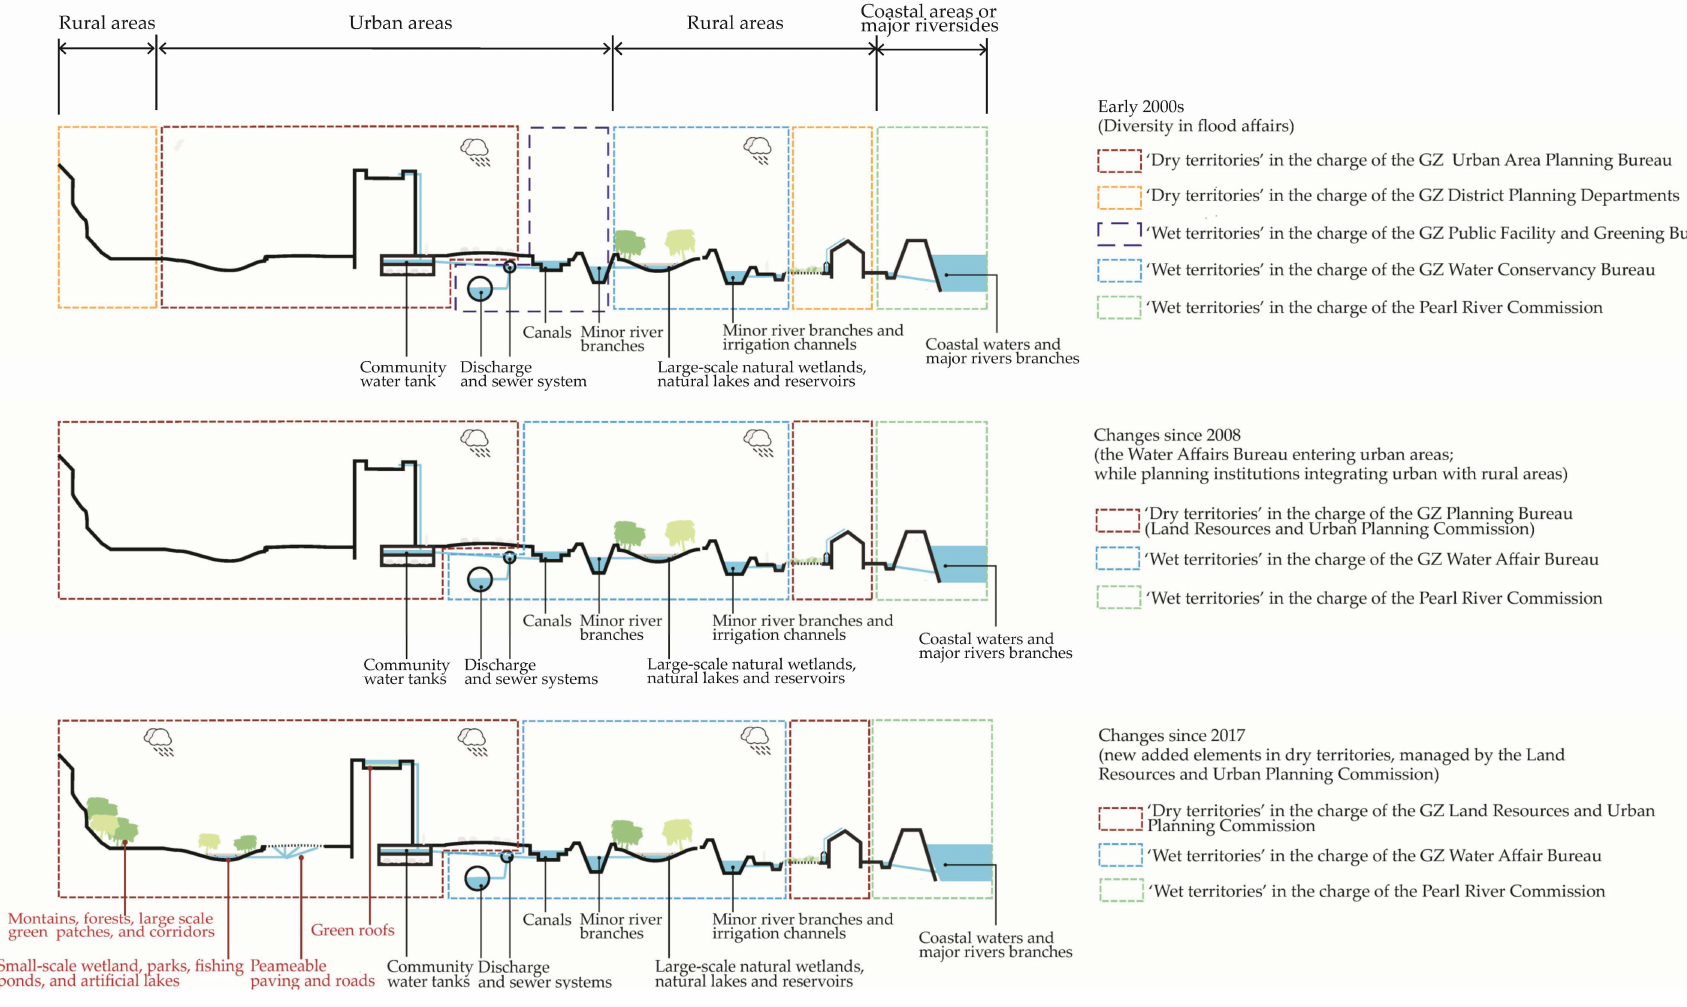
Figure 3. The Responsibilities of the Pearl River Commission, Guangzhou Water Conservancy Bureau (Guangzhou Water Affairs Bureau after 2008), and Guangzhou Urban Planning Bureau (Urban Planning Bureau after 2009 and Land Resources & Urban Planning Committee after